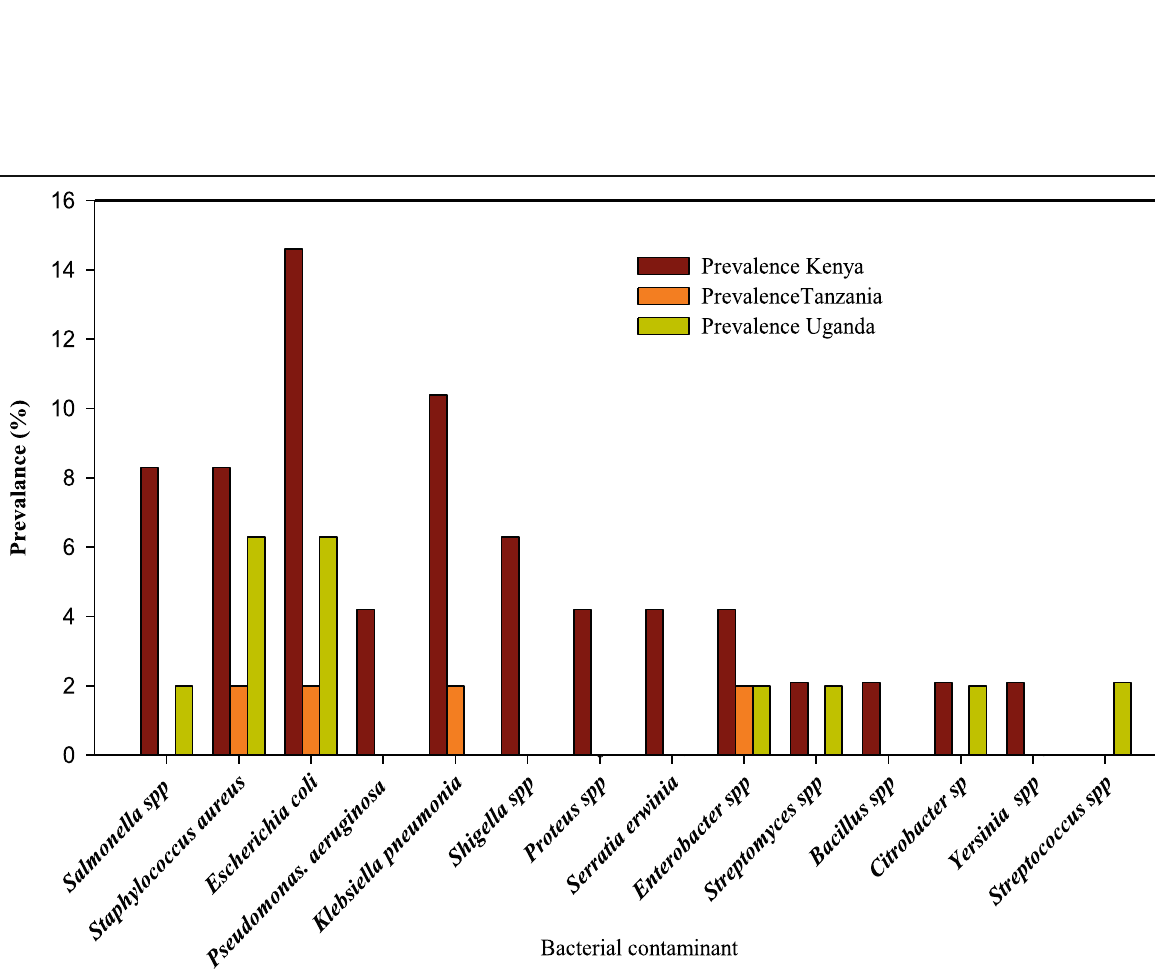
Fig. 3 Bias assessment plot of studies that reported bacterial contamination in herbal medicines sold in East African countries from the year 2000 to